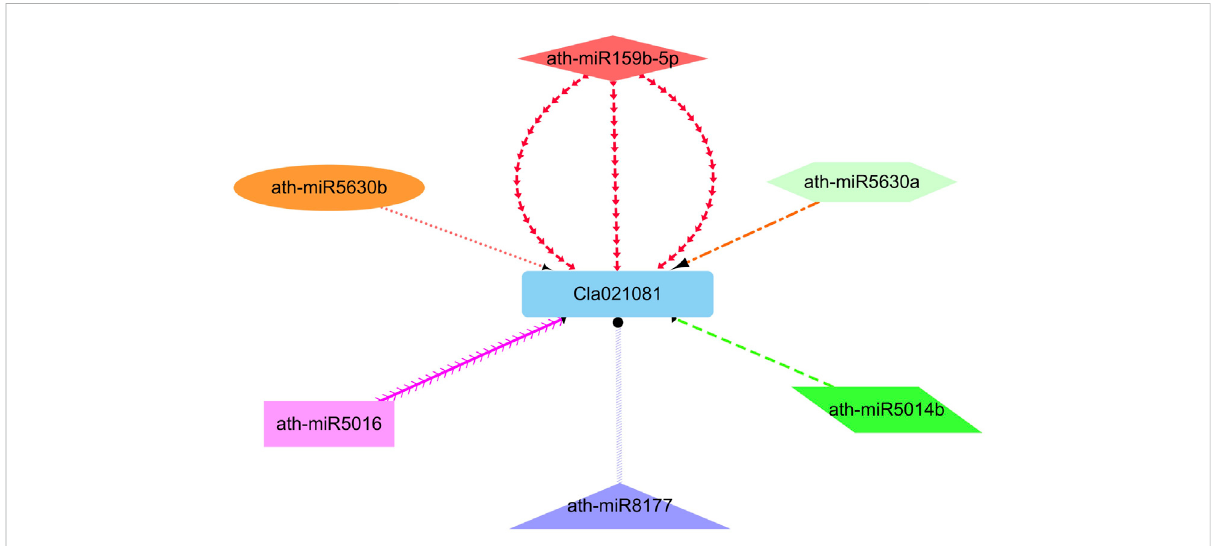
The network representation of the regulatory connections among the predicted miRNAs and ClIQD24 genes. Different colors highlight the interacting